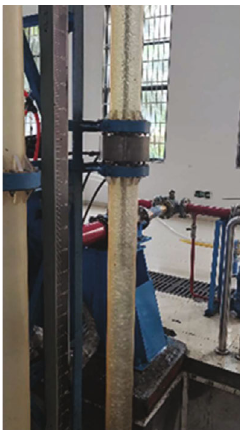
Figure 3: Simulation logging experiment